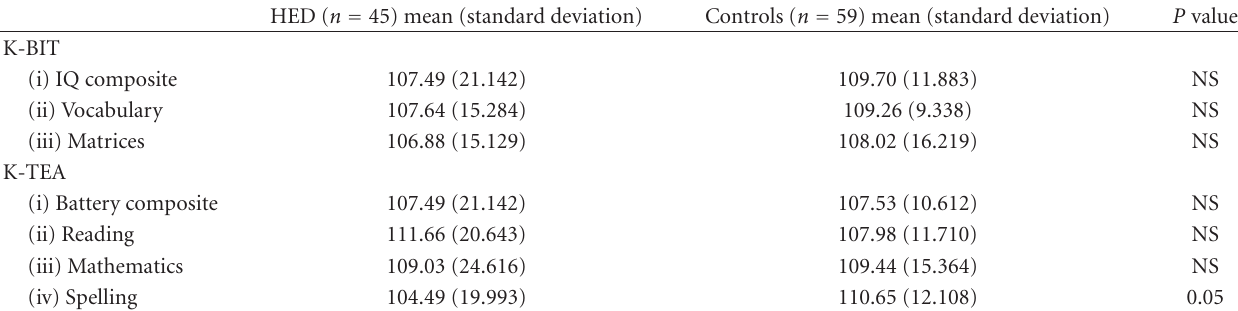
Table 4: Comparative distribution of standard scores on IQ (K-BIT) and educational achievement (K-TEA) in children with HED and control group.